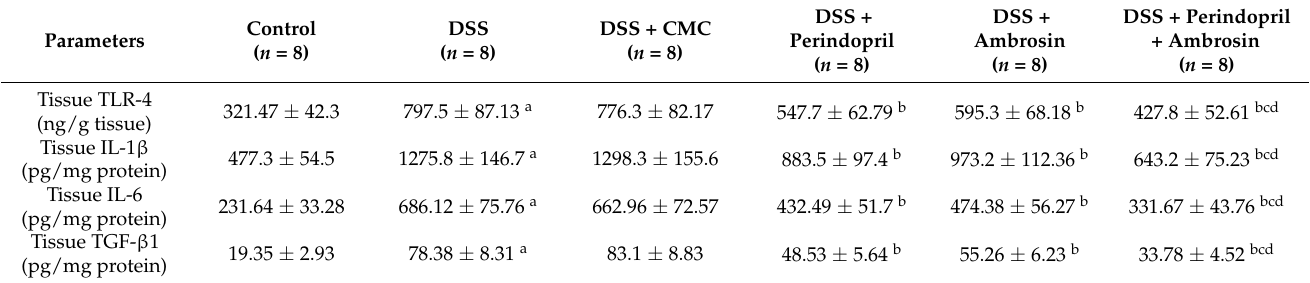
Table 3. Effect of perindopril with or without ambrosin on TLR4, IL-1 β , IL-6, and TGF- β 1 in the colonic tissues of DSS-treated mice (Mean ±